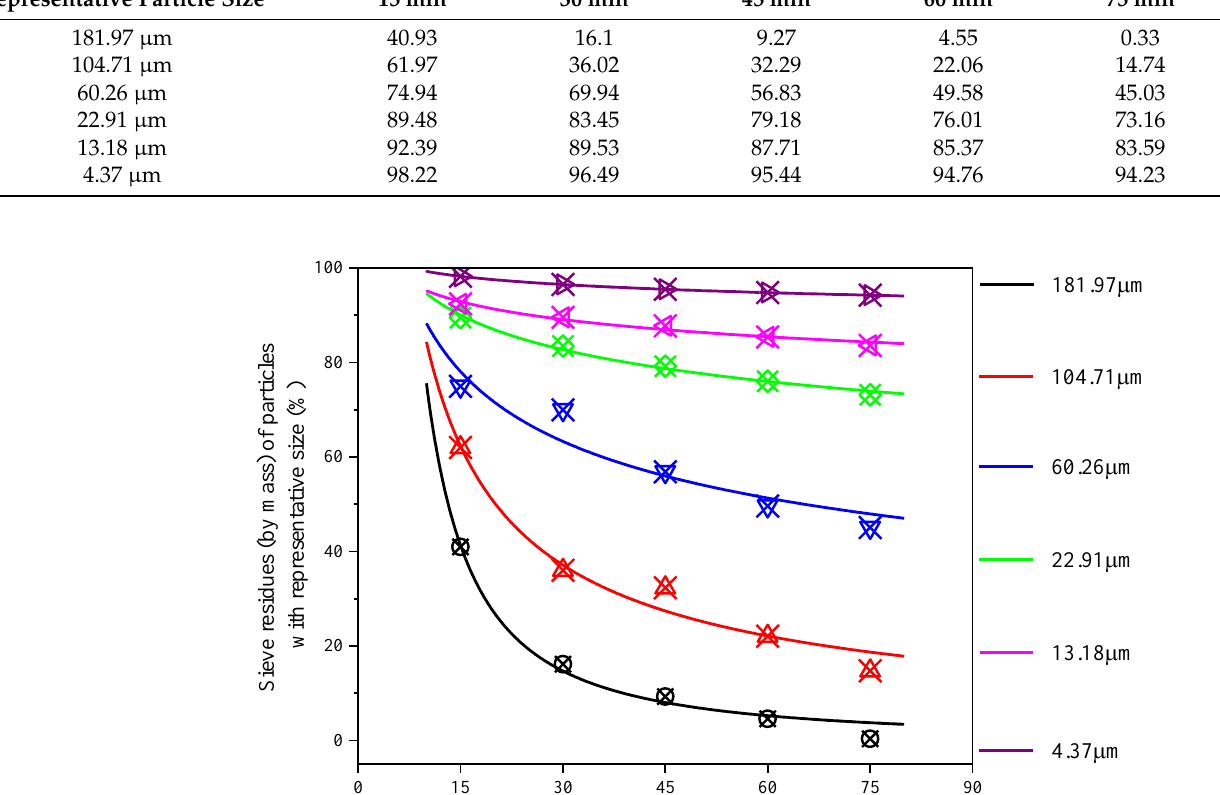
Table 2. The sieve allowance of six representative particle sizes of CGS.